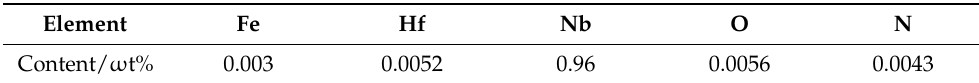
Table 1. Contents of impurity elements in zirconium hydride.